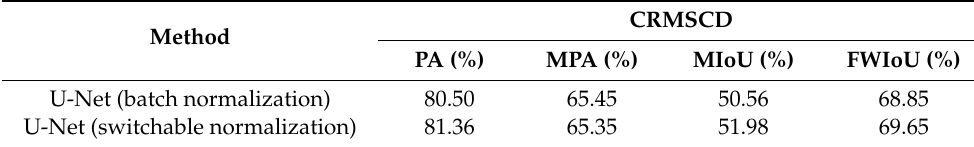
Table 11. Experiment of switchable normalization in convolution layers.